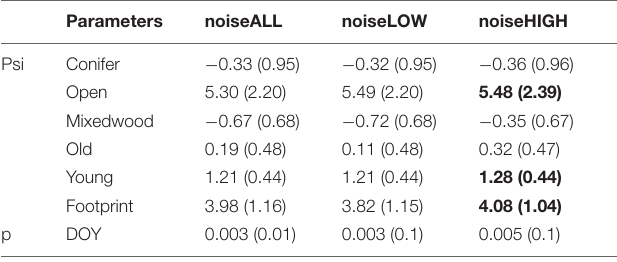
TABLE 6 | Beta estimates ( ± SE) of best occupancy model including the three different noise metrics. The best model included noiseHIGH. Parameters noiseALL noiseLOW noiseHIGH